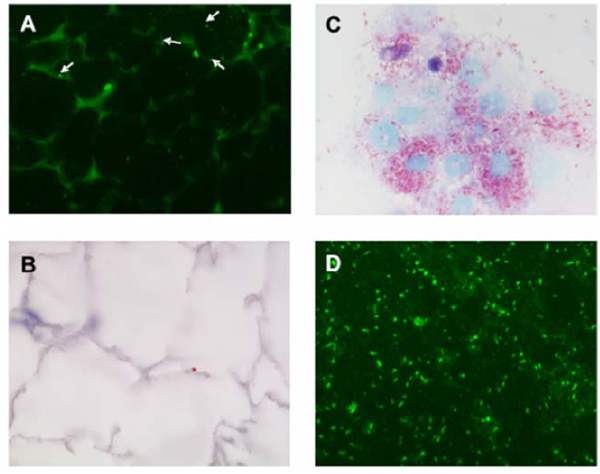
Figure 3. Immunodetection and isolation of R.prowazekii from adipose tissues 4 months after primary infection. Immunofluo- rescence staining showing R. prowazekii rickettsiae in adipocytes (arrows), using an anti-OmpB monoclonal antibody ( A ), and rare staining (red-brown) using an immunoperoxidase technique with a polyclonal anti- R. prowazekii antibody ( B ). Gimenez ( C ), and immuno- fluorescence ( D )-stained preparations of intracellular R. prowazekii rickettsiae, isolated from murine adipose tissues in L929 cells. Original magnifications 6 400.